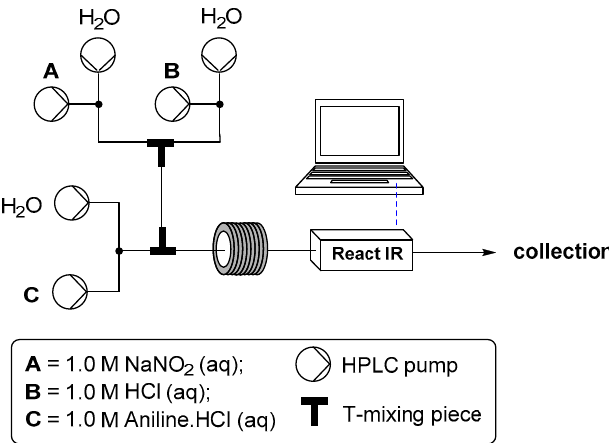
Figure 1. Configuration of flow reactors for diazonium formation using aqueous conditions.